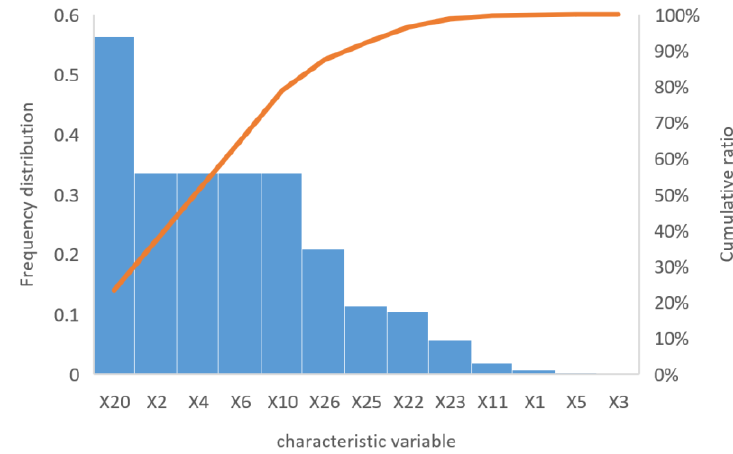
Figure 4. Frequency distribution of the original variables in PCA.